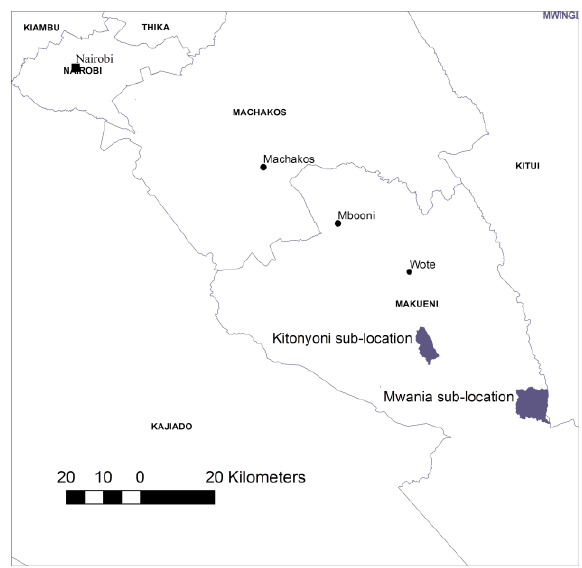
Figure 1. Location of control (Mwania) and intervention (Kitonyoni) sub-locations in Kenya.